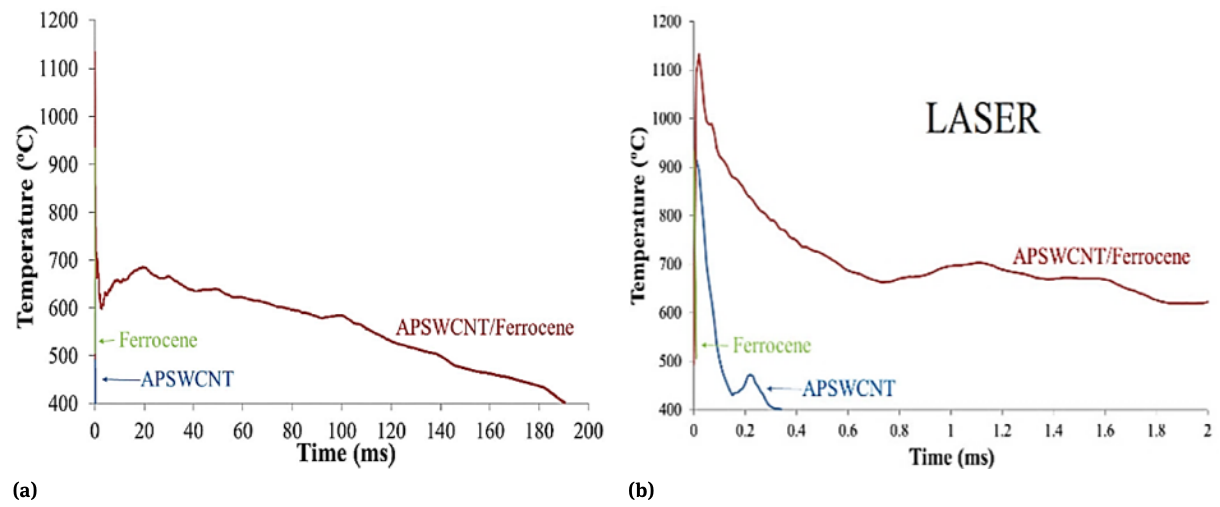
Figure 2: Laser initiation of APSWCNT/ferrocene (1:2, 10 mg) sample, with a pulse energy of 152 mJ (a) and view of the expanded short time region (from 0ms to 2ms) (b) [15].